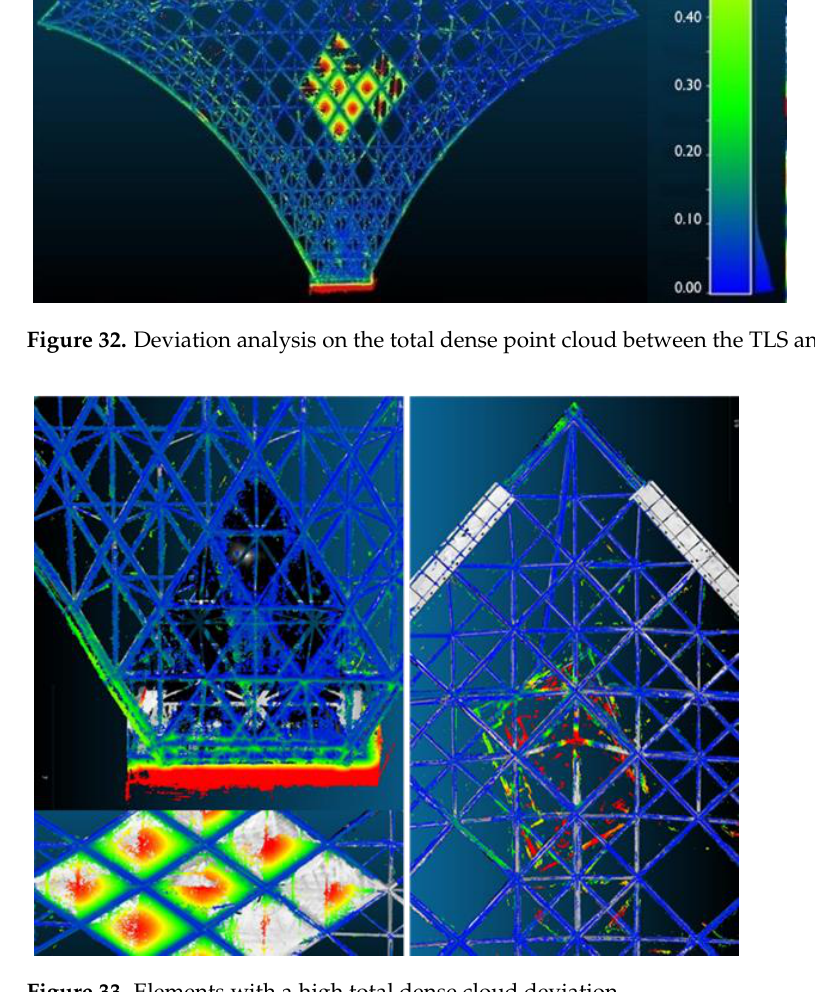
Figure 33. Elements with a high total dense cloud deviation.